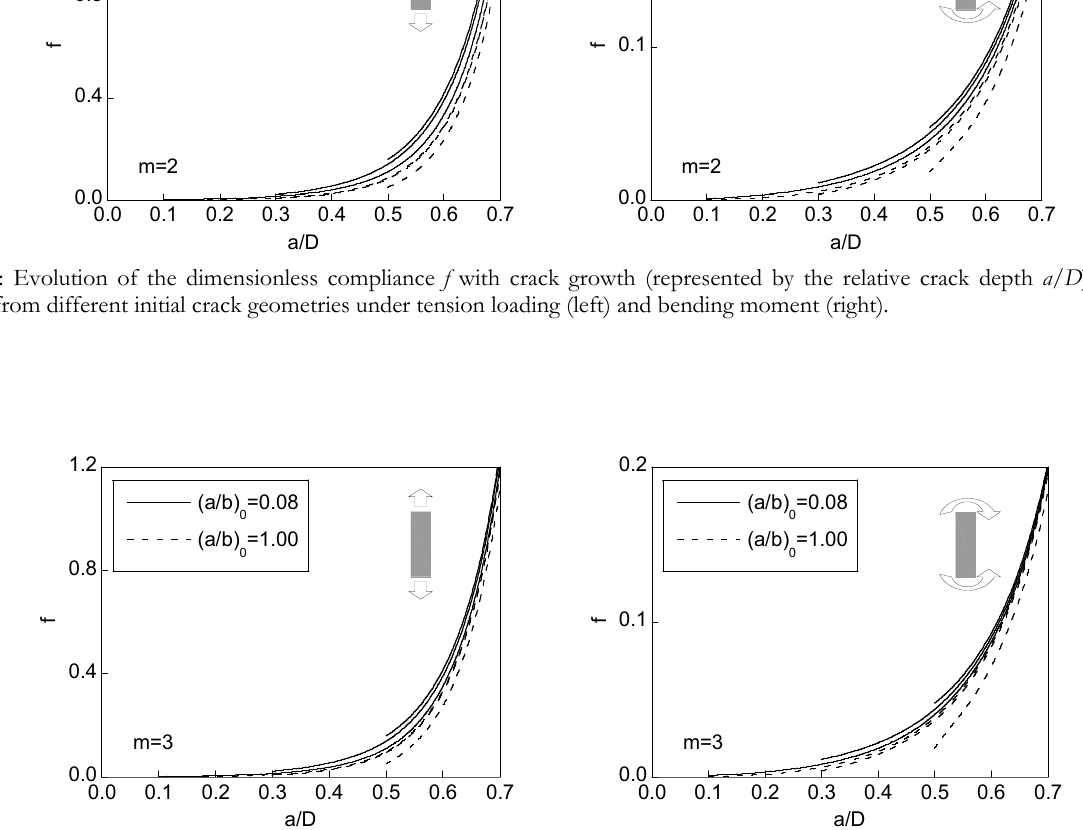
Figure 9: Evolution of the dimensionless compliance f with crack growth (represented by the relative crack depth a / D ) for m =3, starting from different initial crack geometries under tension loading (left) and bending moment